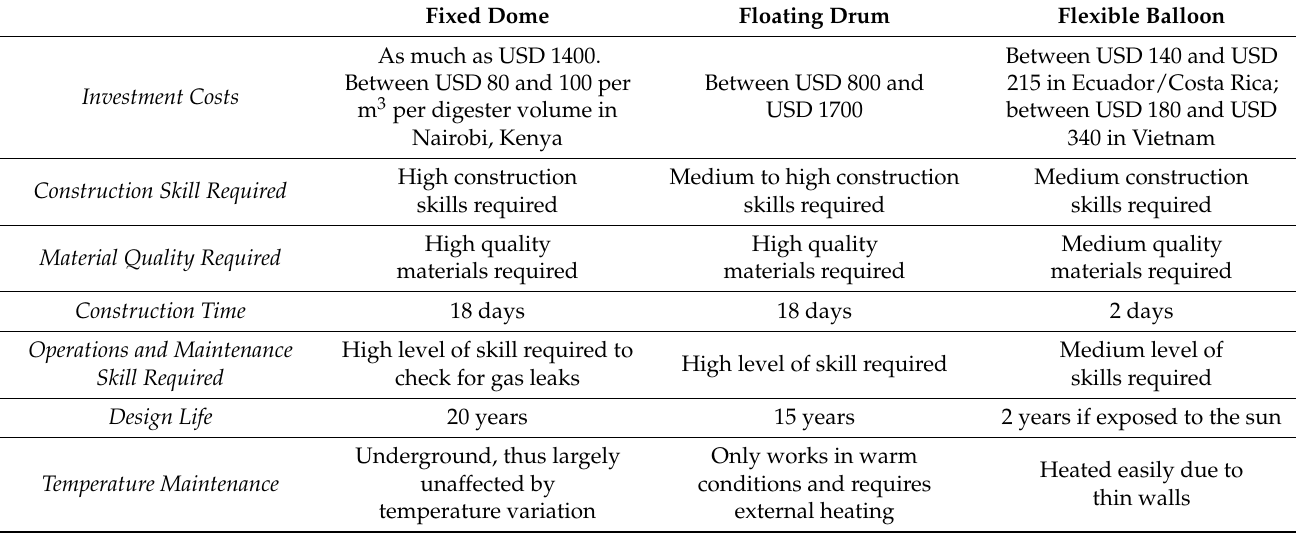
Table 3. Characteristic comparison of fixed dome, floating drum and flexible balloon digesters. Fixed Dome Floating Drum Flexible